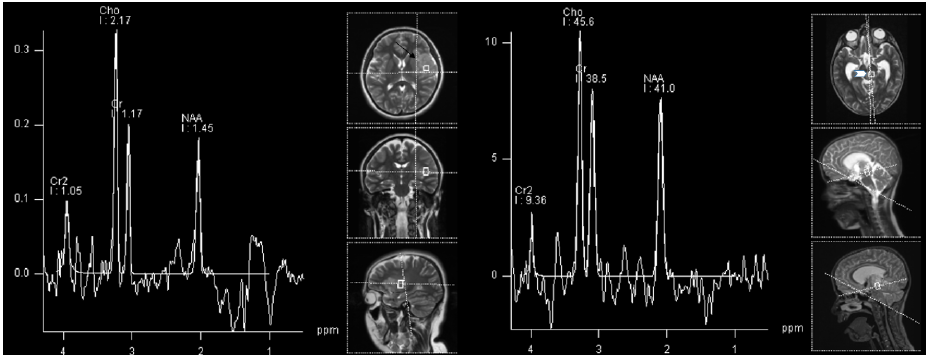
Figure 2. 1H-MRS in a patient (15 Y) with astrocytoma grade 3 ( left , black arrow) and in a patient (8 Y) with astrocytoma WHO grade 2 ( right , white arrowhead). Similar spectra are present in both grade 3 and grade 2 astrocytoma with increased Cho and decreased NAA, with the absence of Cr